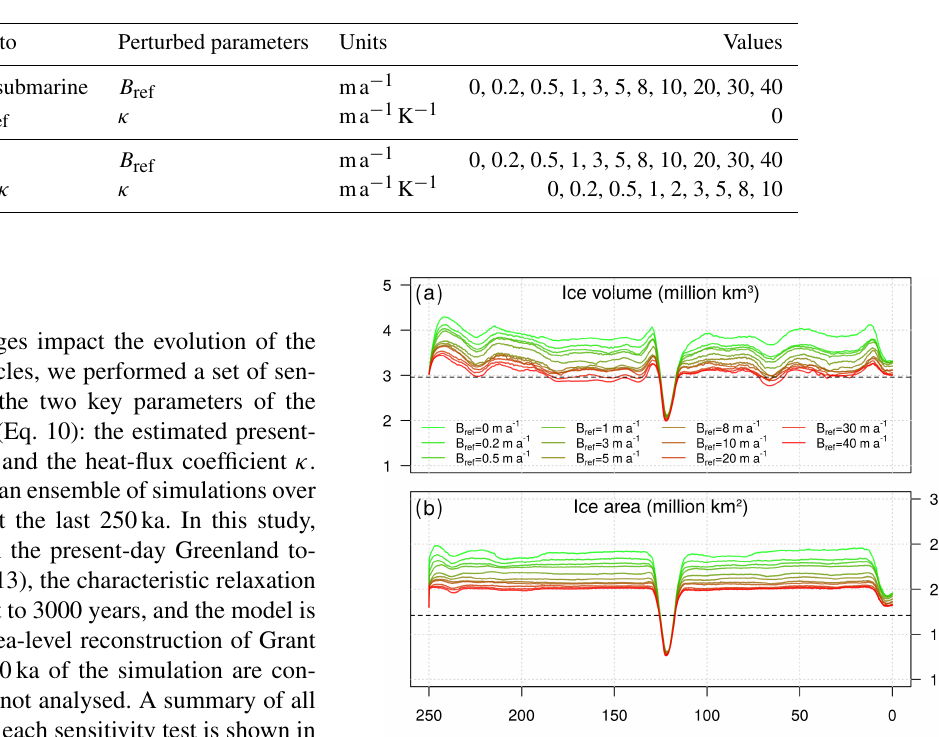
Table 1. Summary of all parameter values used to perturb the basal melting rate equation (Eq. 10) in each sensitivity test.